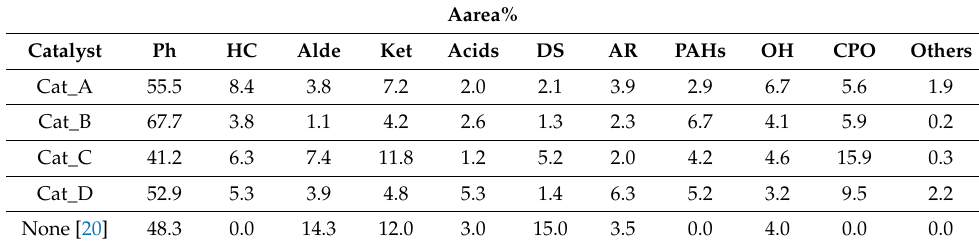
Table 2. Bio-oil product functional group distribution obtained from GC-MS